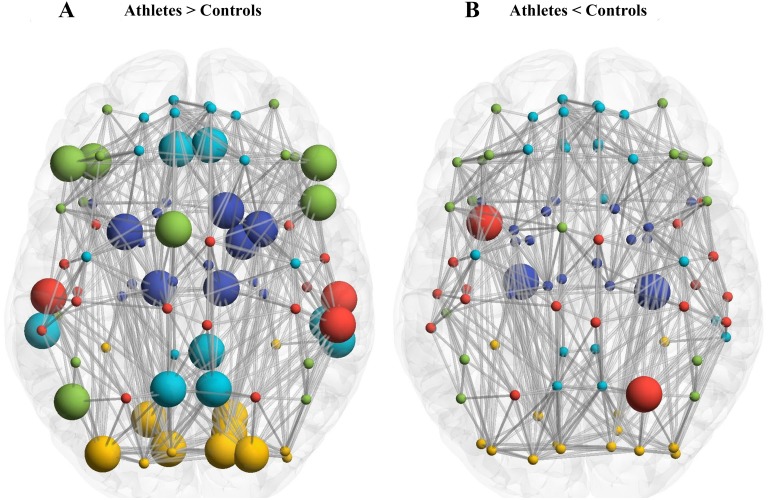
Comparison of regional parameters between athlete and control groups.A shows the bigger node size of brain networks in athletes group with higher regional parameters compared to the control group. B shows the bigger node size of brain networks in the control group with higher regional parameters relative to the athlete group. Red nodes indicate the sensorimotor network while yellow nodes indicate the visual network, green nodes the attention network, light blue nodes the default-mode network, and the dark blue nodes the limbic/subcortex network.